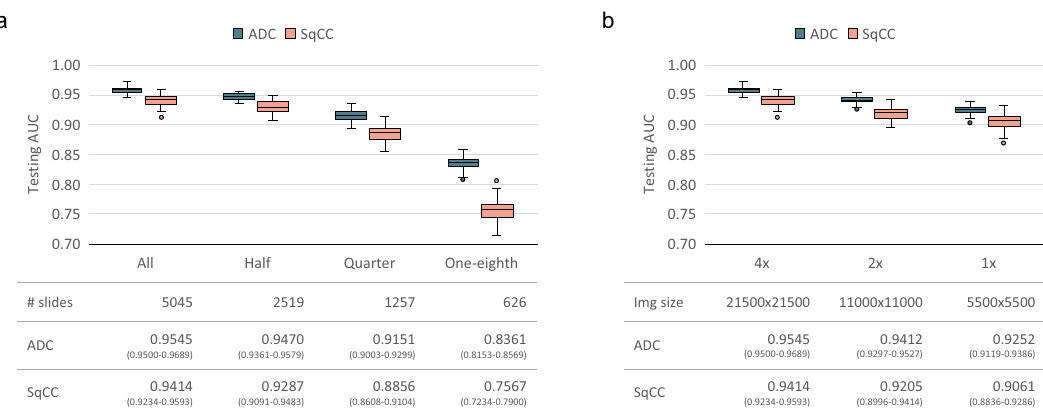
Fig. 5 Data set size and image resolution impact on whole-slide training method. The performances were measured by area under the ROC curve (AUC) of classifying adenocarcinoma (ADC, dark blue box-and-whiskers) and squamous cell carcinoma (SqCC, red box-and-whiskers) over the standard testing data set ( n = 1397). The AUC distribution of each con fi guration was obtained based on the sampled AUCs by bootstrapping over 100 iterations. A box- and-whisker is drawn to represent each distribution with center (Q2, the median AUC), bounds of box (Q1 and Q3, the fi rst and third quartiles of AUC), bounds of whiskers (the minimal and maximal AUCs within the range obtained by adding Q2 by ±1.5 times the distance between Q3 and Q1), and outlier points (AUCs out the range). The tables below report the exact AUC without bootstrapping and the con fi dence interval calculated by Delong ’ s method of each con fi guration. a Performance of models trained with reduced numbers of slides. b Performance of models trained with lower image testing data set (AUC = 0.9594 [0.9500 – 0.9689], P = 1.987e − 9).